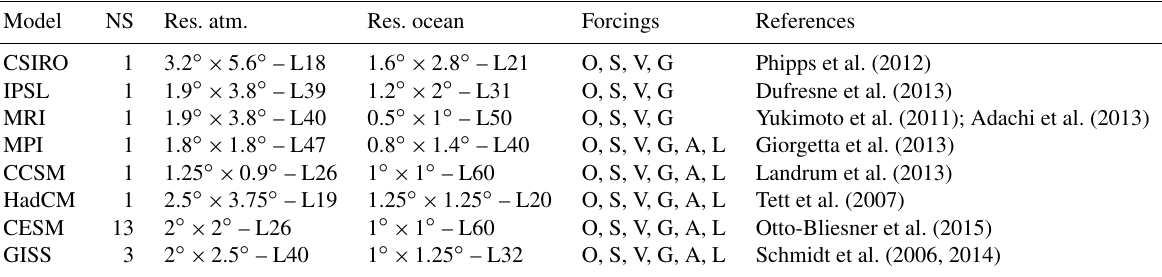
Table 1. CMIP5/PMIP3 models analyzed in this work, including the number of simulations considered in the analyses (NS), the resolution of the atmosphere and ocean components (latitude, longitude, and levels), the forcing factors considered in the simulations (O – orbital; S – solar; V – volcanic; G – greenhouse gases; A – aerosols; L – land use and cover; according to Masson-Delmotte et al., 2013), and the references for the model experiments. All simulations span the period 850–2005CE. This interval will be referred to herein as LM even if within PMIP3 LM only includes 850–1850CE. For the case of CMIP5/PMIP3 simulations, the past1000 and historical experiments have been concatenated to cover this